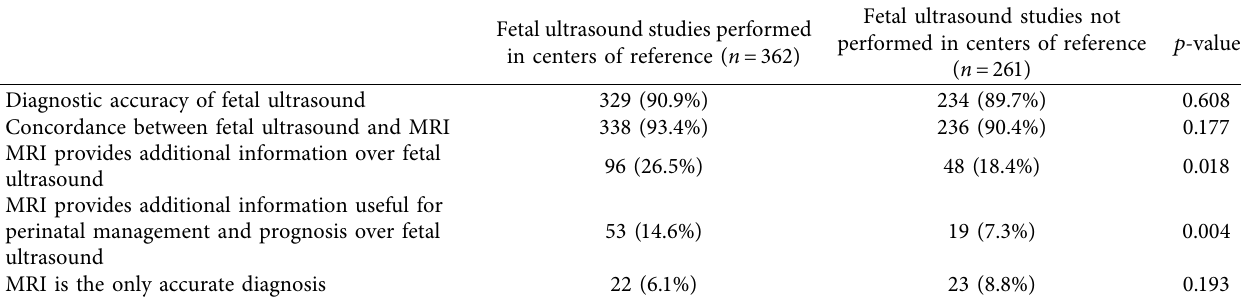
Table 6: Diagnostic accuracy of the fetal ultrasound relative to postnatal diagnosis, concordance, and usefulness of fetal MRI of the 623 cases referred from reference and non-reference ultrasound